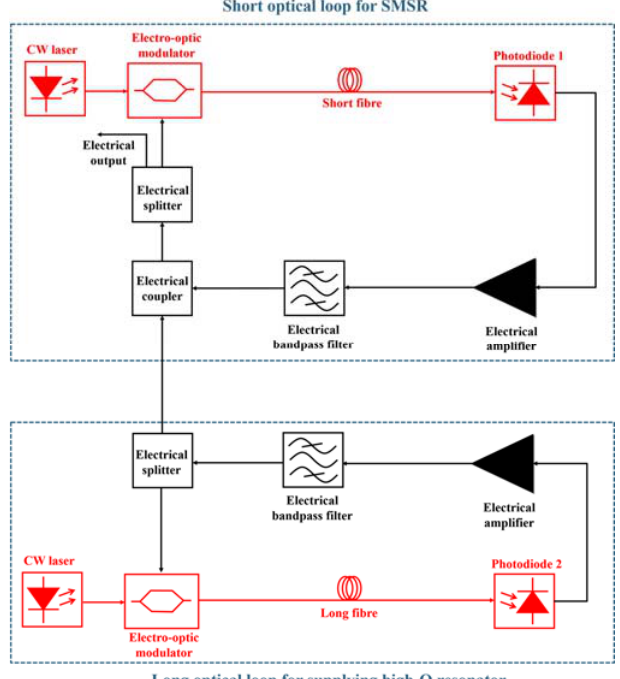
Figure 4. Typical injection-locked OEO.